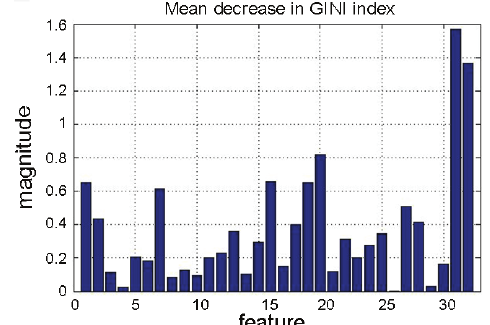
Fig. 3. Mean decrease in GINI index